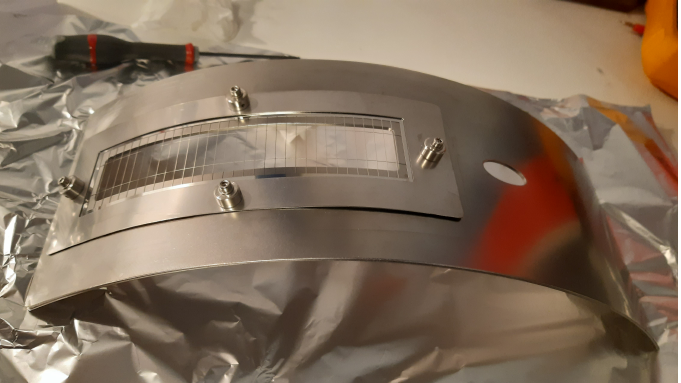
Figure 4. The rectangular hole and grid on the outer curved electrodes of the second version of the